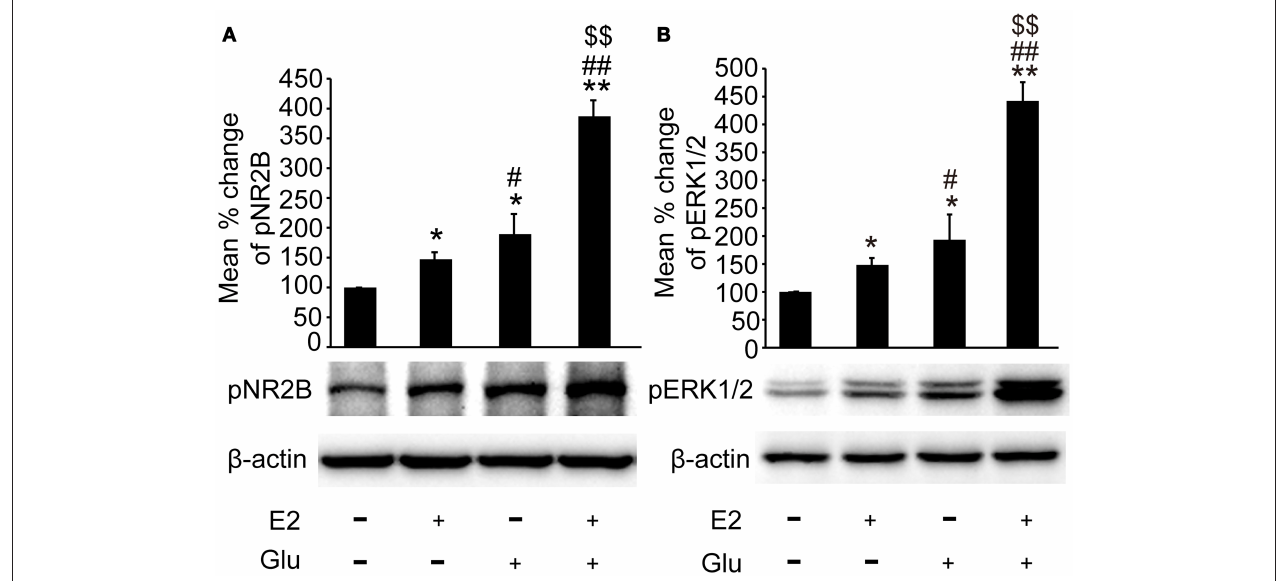
FIGURE 6 | E2 potentiated glutamate-evoked pNR2B and pERK1/2 upregulation in the hippocampus. OVX rats were assigned to 4 groups for western blot analyses: (1) no injections, (2) E2 replacement, (3) glutamate injections, and (4) E2 replacement combined with glutamate injections. (A, B) Representative western blots of pNR2B and pERK1/2 after E2 and glutamate treatment. Quantification of protein levels was normalized against loading control β -actin and presented as the relative density compared with the control group. * P < 0.05, ** P < 0.01 vs. control group (OVX); # P < 0.05, ## P < 0.01 vs. E2 group; $$ P < 0.01 vs. Glu group; n = 5, per group. OVX, ovariectomy; E2, 17 β -estradiol; Glu, glutamate; pNR2B, phosphorylated NR2B subunit of the N-methyl-D-aspartate receptor; pERK1/2, phosphorylated (p44/42) mitogen-activated protein